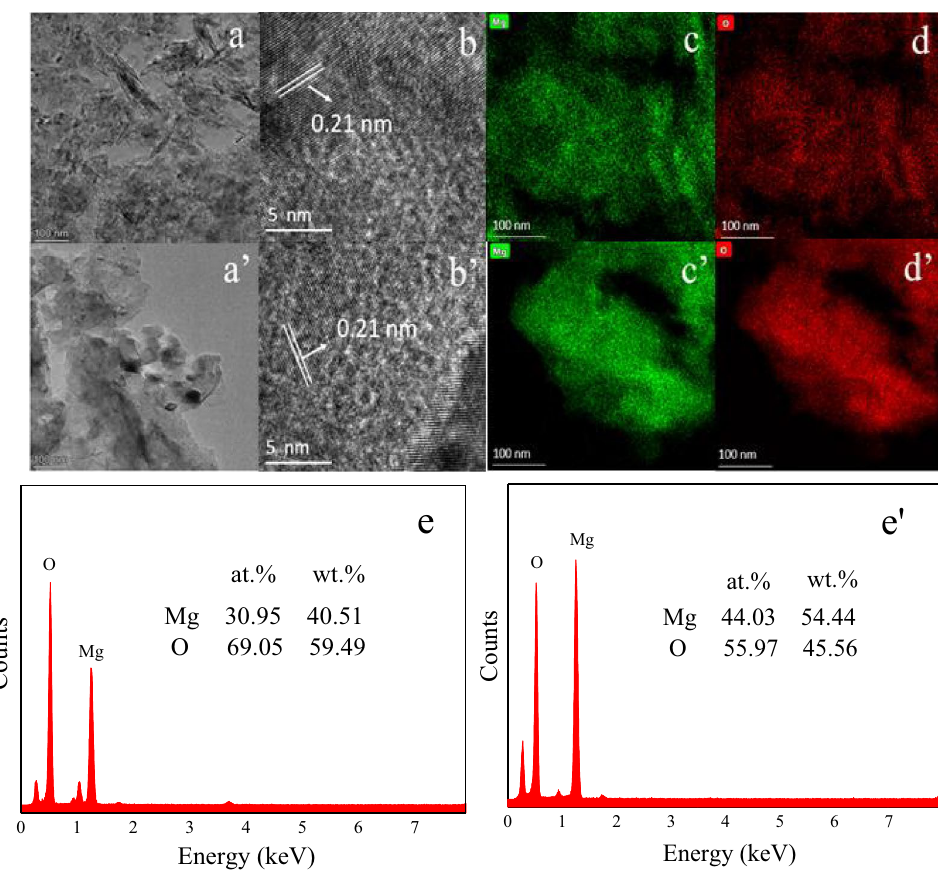
Figure 10. TEM images of MgO-P-NaOH-3 ( a ) and MgO-P- Na 2 CO 3 -3.14 ( a’ ). HR-TEM images of MgO-P- NaOH-3 ( b ) and MgO-P- Na 2 CO 3 -3.14 ( b’ ). TEM mapping analysis of Mg and O elements on the surface of MgO-P-NaOH-3 ( c , d ) and MgO-P- Na 2 CO 3 -3.14 ( c’ – d’ ). EDS analysis of MgO-P-NaOH-3 ( e ) and MgO-P- Na 2 CO 3 -3.14 ( e’